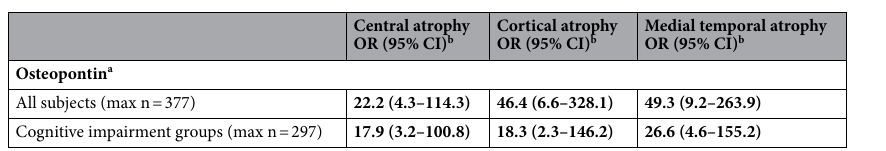
Table 5. Association between osteopontin and brain atrophy, expressed in odds ratios (OR) and 95% confidence interval (CI). Bold values indicates p < 0.05 using binary logistic regression. CeVD, cerebrovascular disease; WMH, white matter hyperintensities; ARWMC, age-related white matter changes; max n, maximum number; OR, odds ratio; CI, confidence interval. a Log-transformed. b Adjusted for age, gender, education, hypertension, diabetes and heart disease.